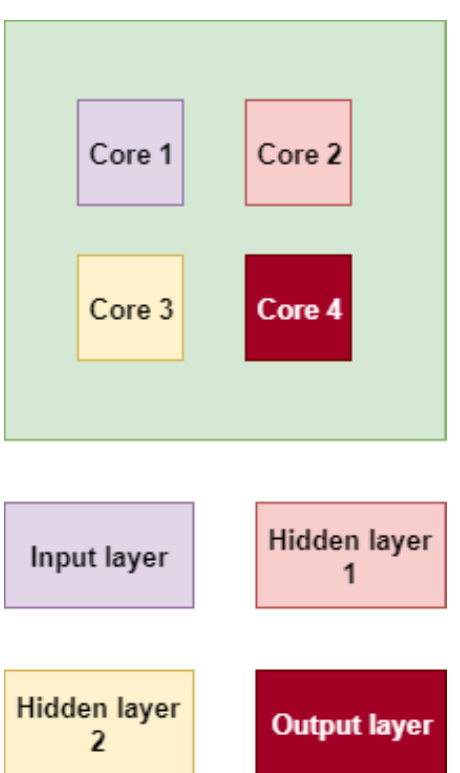
Figure 6. Level-1 mapping for four-cores architecture using multilevel mapping technique.